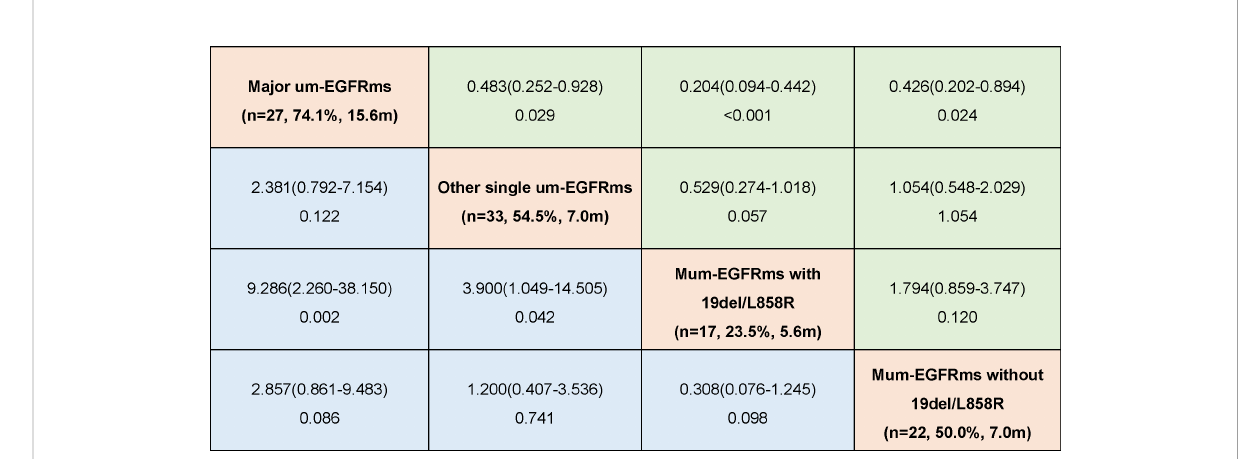
FIGURE 7 Odds ratio (ORa) with 95% CI for objective response rate (ORR) (blue)and hazard ratio (HR)with 95% CI for progression free survival (PFS)(green) in subgroup analysis according to mutation patterns (OR and HR was set by column versus